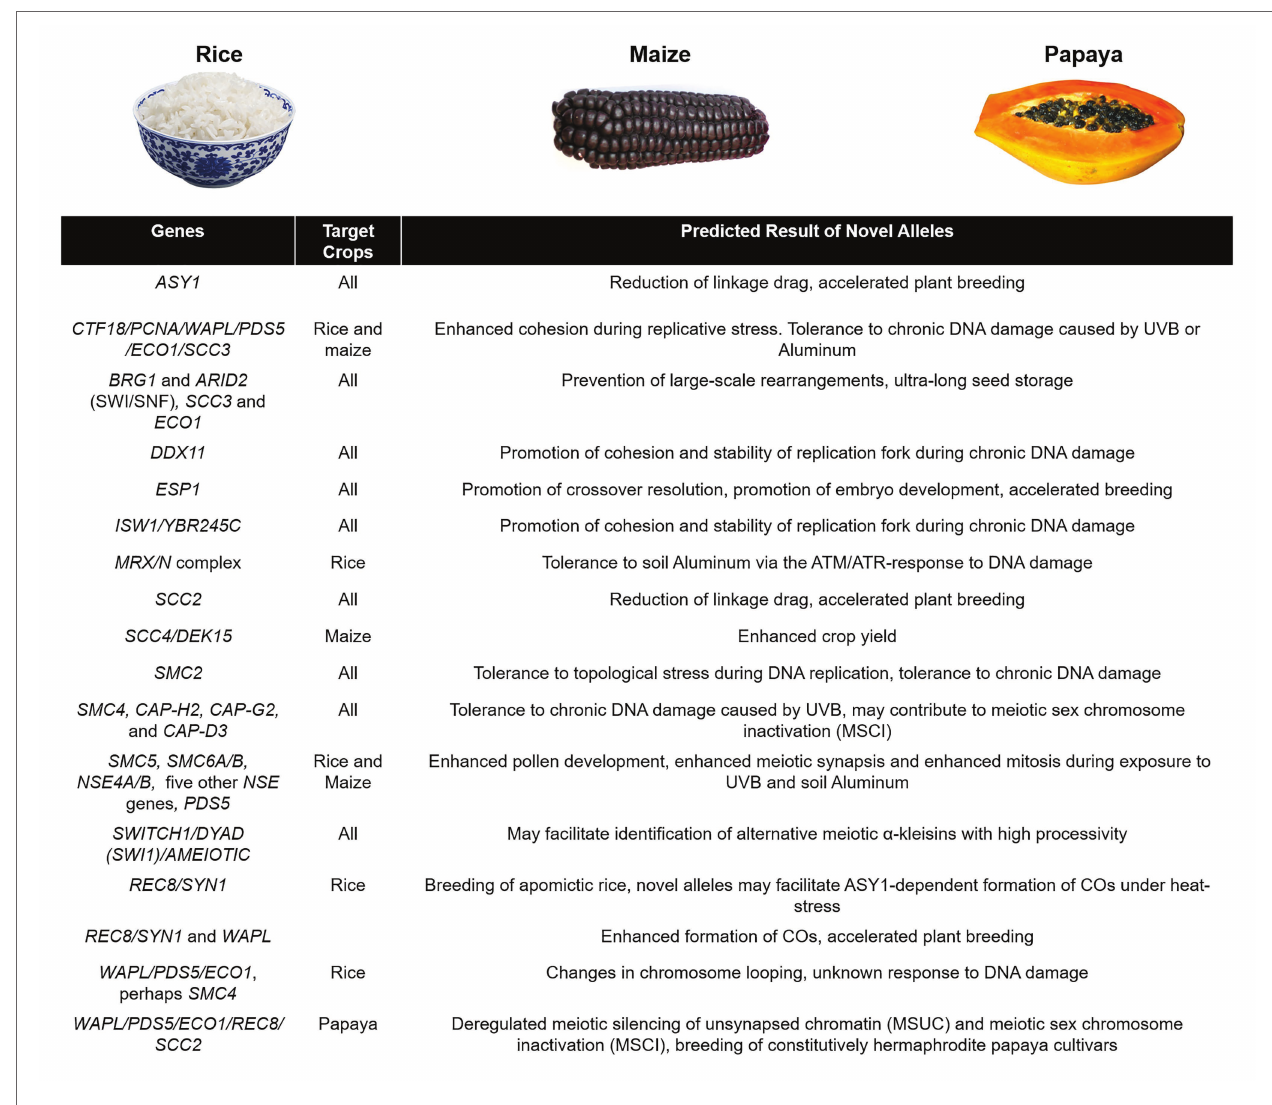
FIGURE 6 | Suggested agricultural targeting of genes involved in SMC-regulated processes. In major crops such as rice and maize, it might be possible to stabilize transcription and homologous recombination under chronic stress caused by UVB radiation and soil aluminum, and in the case of papaya, it might be possible to